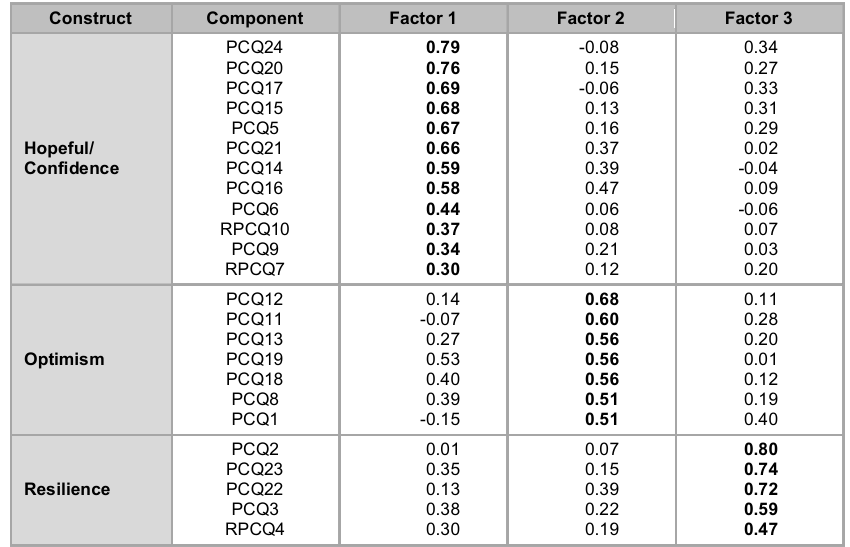
Rotated factor pattern for PSA-PsyCap (3-Factor) Construct